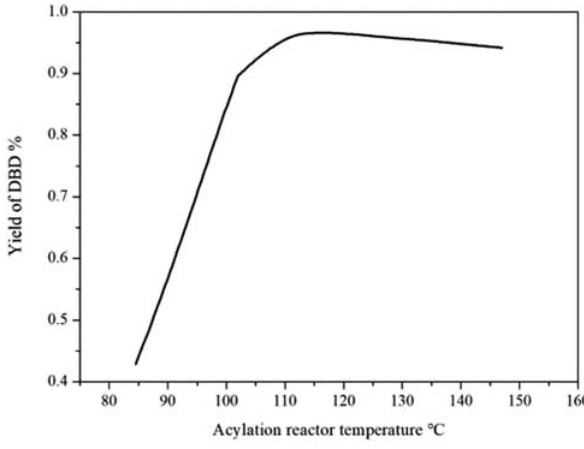
Figure 10: Relationship between the acylation reactor temperature and the DBD yield.